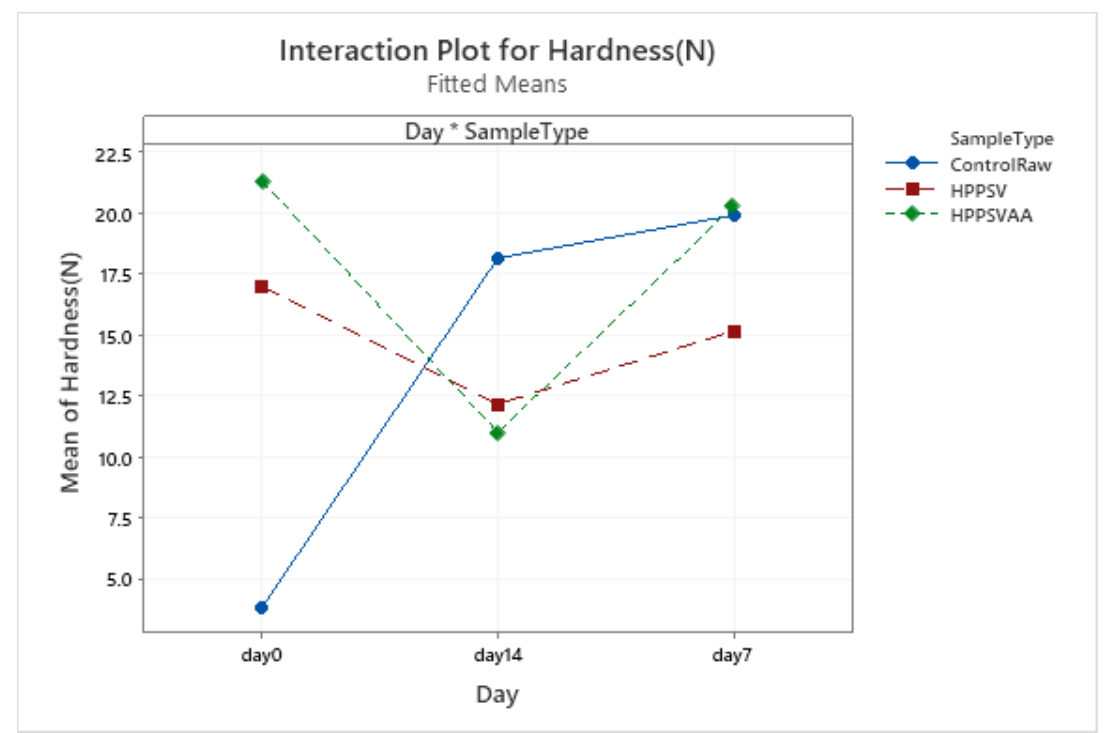
Figure A9. Effect of treatments and storage time on the hardness of hybrid patty (HPPSV: HPP- SVCOOK).